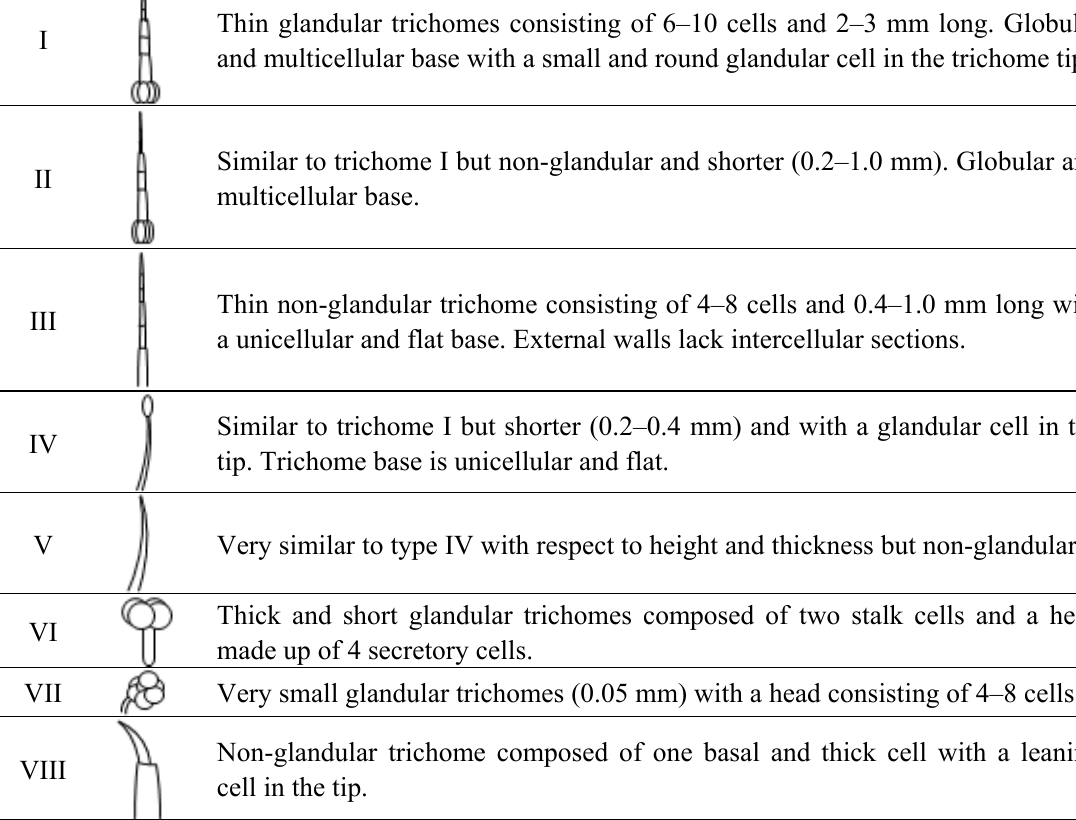
Table 1. Trichome description according to Luckwill [20] and revised by Channarayappa et al. [21].